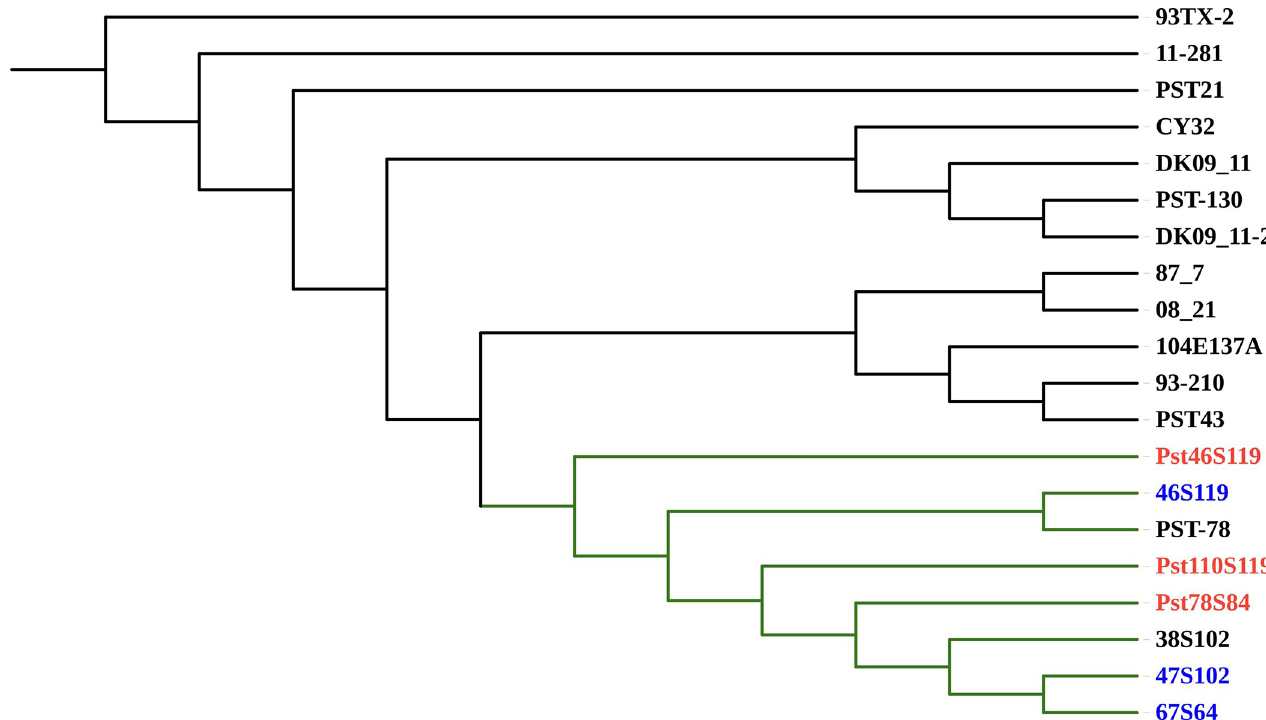
Fig 7. Phylogenetic tree based on the orthologous gene alignment of conserved BUSCO genes in 20 Pst pathotypes: USA (11–281, 93–210, 93TX-2, PST- 78, PST-130, PST21, PST43), UK (08/21, 87/7), Denmark (two assemblies for DK09_11), Australia (104E137A), China (CY32), India (38S102, 46S119, 47S119, 67S64) and Pst110S119, Pst46S119, Pst78S84.